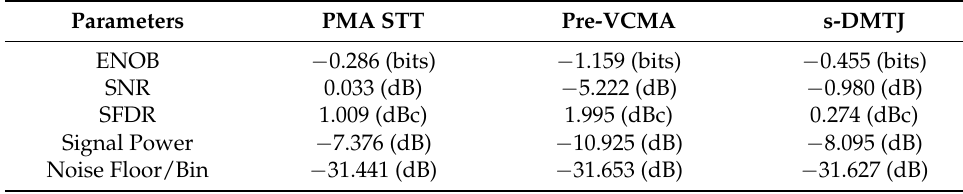
Table 5. Spectrum Analysis data for different 2T MTJ devices in the test circuit.